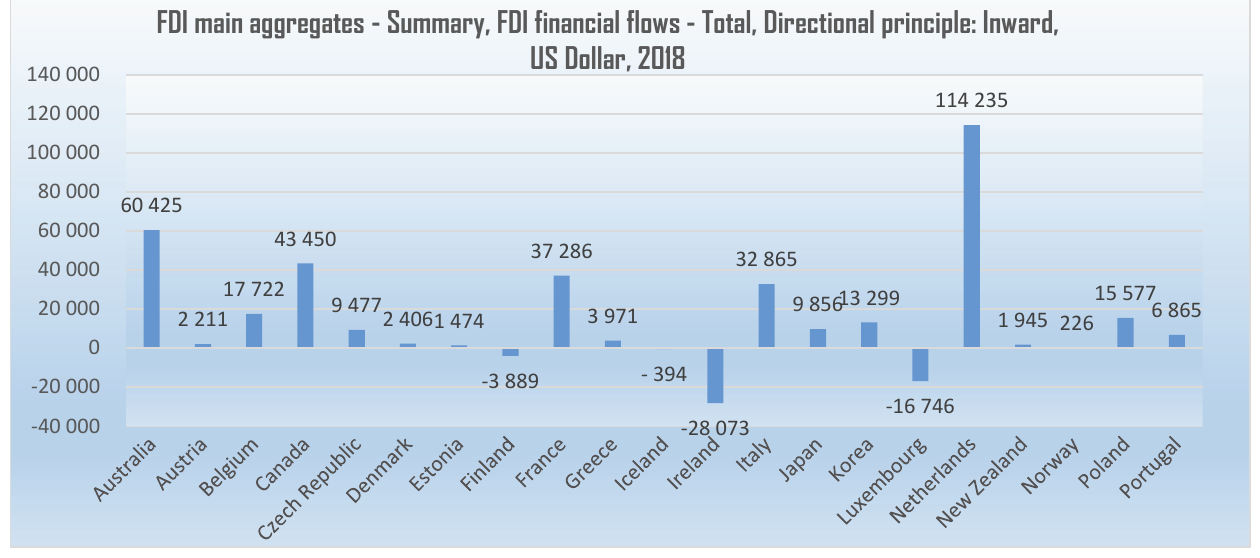
Fig. 2. FDI, Financial flows